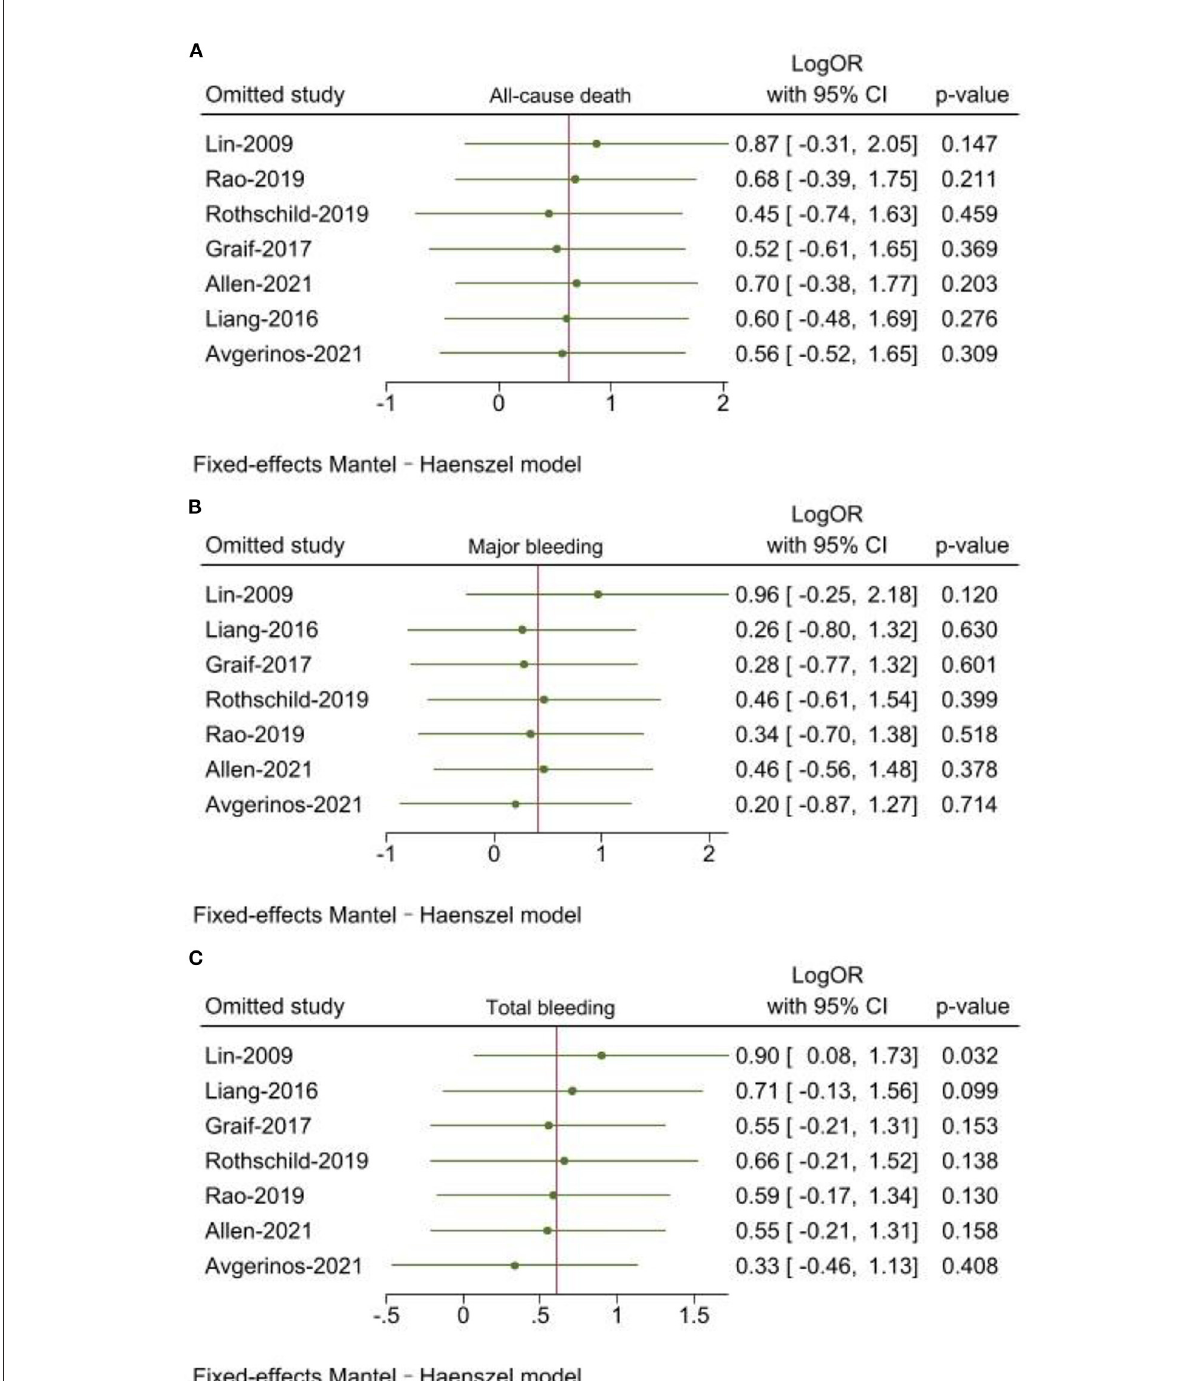
FIGURE4 (A–C) Sensitivity analysis of all-cause death, major bleeding and total bleeding.